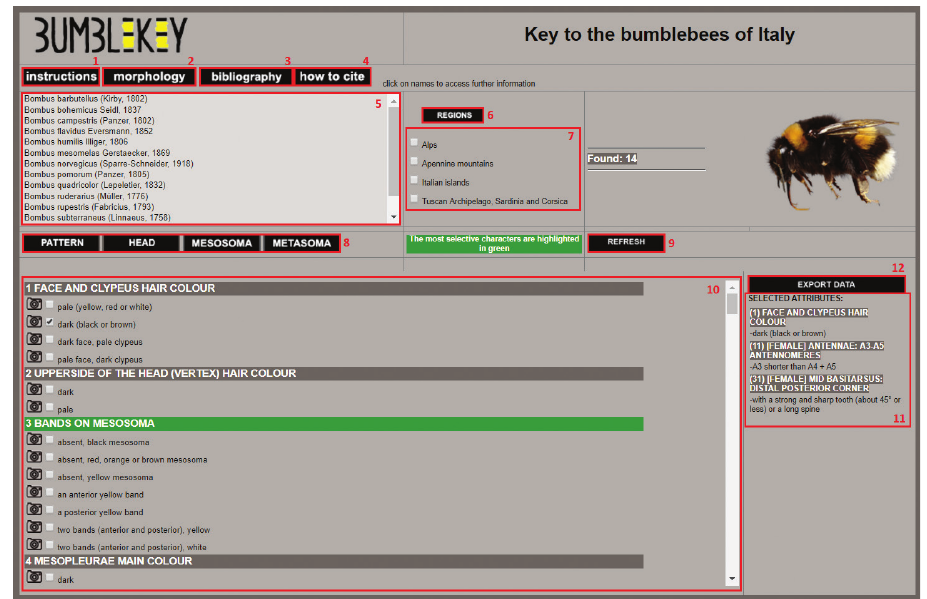
Figure 2. Interactive key main